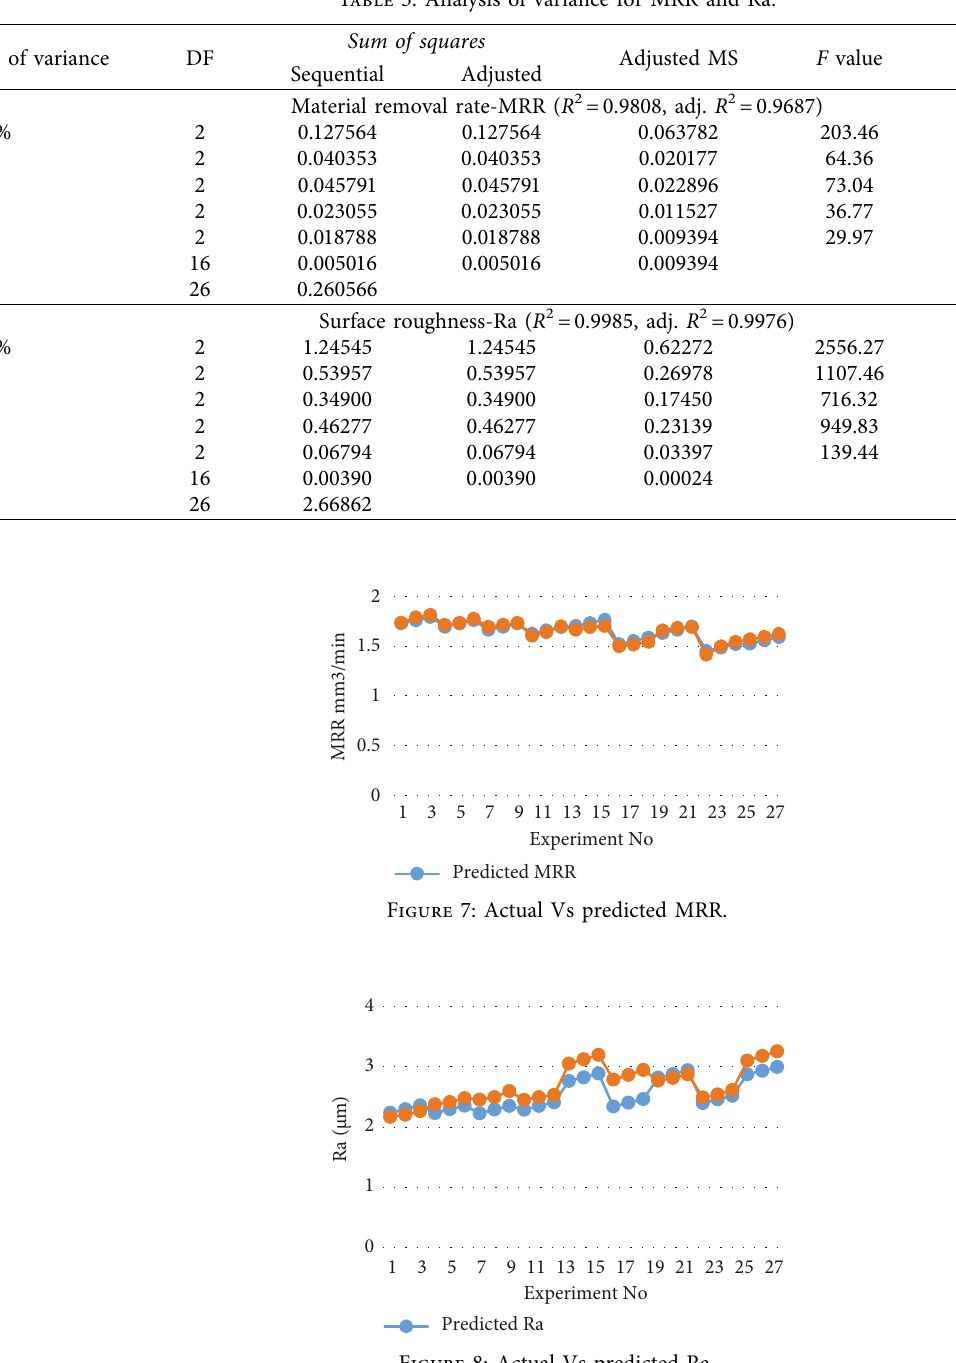
Table 5: Analysis of variance for MRR and Ra.